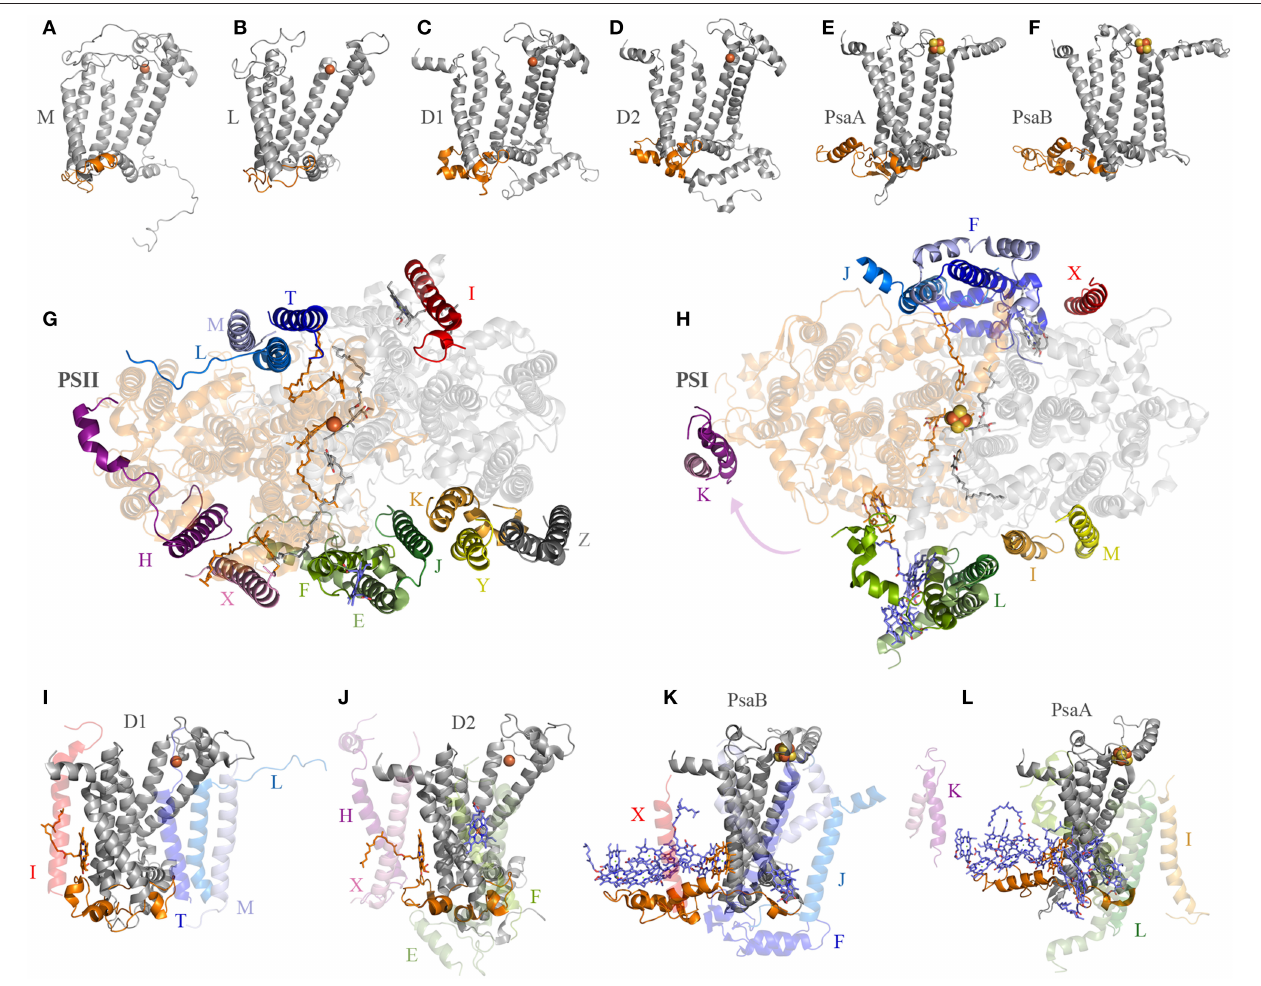
FIGURE 4 | Interaction of reaction center proteins and the small peripheral subunits. Panels (A–F) show the reaction center proteins of the anoxygenic Type II reaction center of Blastochloris viridis (M and L, PDB ID: 2PRC), Thermosynechococcus vulcanus (D1 and D2, PDB ID: 3WU2), and Thermosynechococcus elongatus (PsaA and PsaB, core domain only, PDB ID: 1JB0). The orange colored cartoon highlights the protein segment found between the 1st and 2nd transmembrane helices of the core proteins (7th and 8th in Photosystem I). Panels (G,H) show the position of the peripheral subunits of Photosystem II and Photosystem I. Panels (I–L) show the interaction of the core proteins with some of the small subunits and nearby